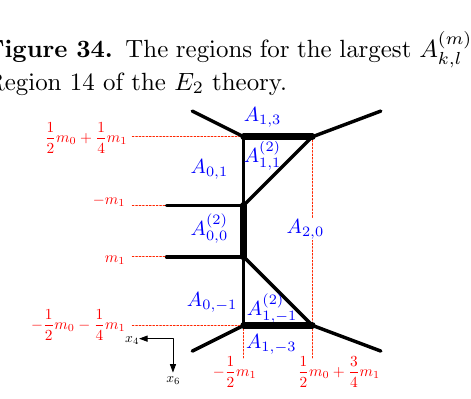
in Figure 36. The regions for the largest A ( m ) k;l Region 16 of the E 2